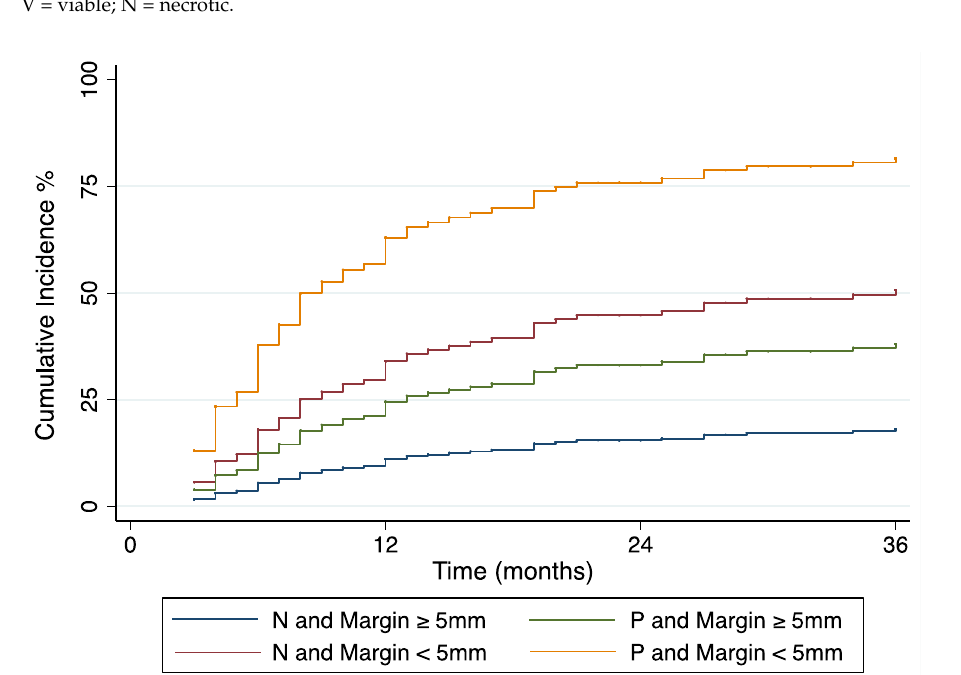
Figure 2. Kaplan–Meier curve of local tumor progression free survival stratified by post-ablation biopsy result (N: Negative or P: Positive) and ablation margin size.